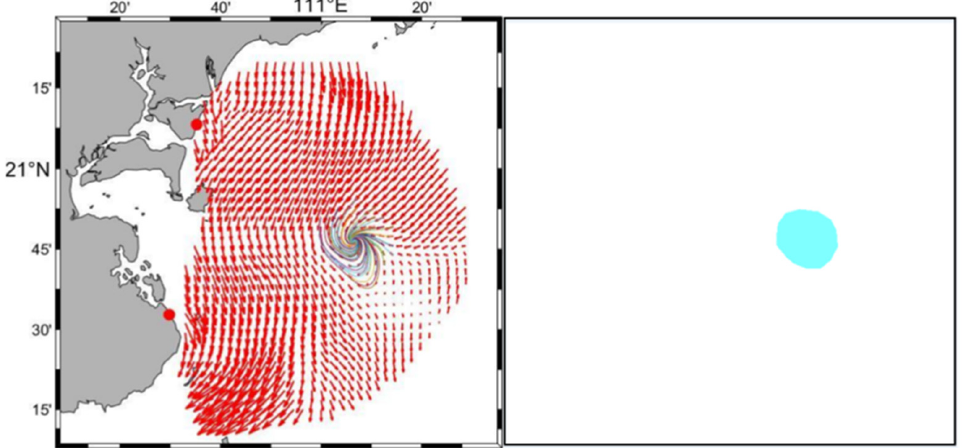
Figure 3. Example of the pixel segmentation training couple.